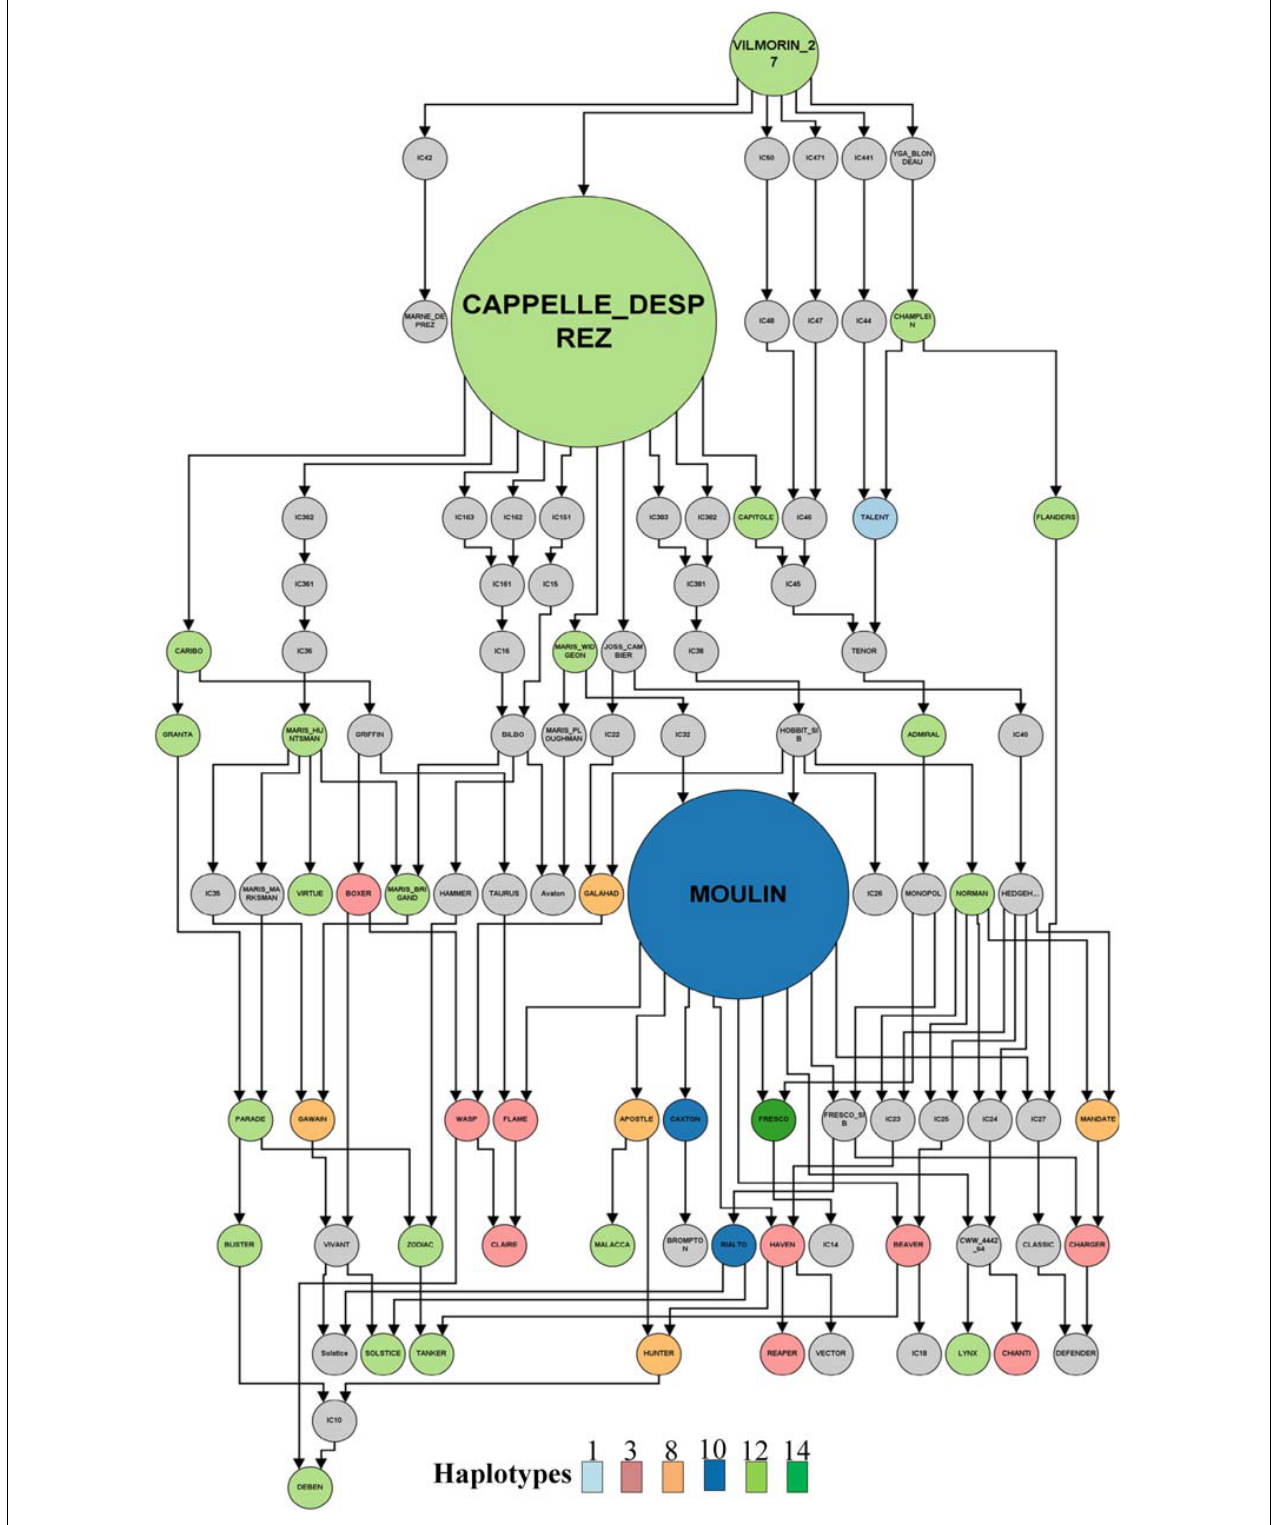
FIGURE 5 | Pedigree of selected United Kingdom and European varieties highlighting the origin of the major resistant haplotype (H12). Each circle represents a variety and colors represent the different haplotypes. Nodes are size based on the number of varieties derived from the node.